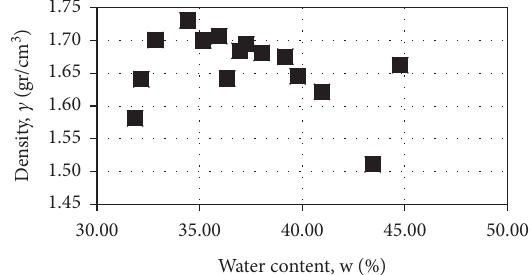
Figure 5: Decreased water addition.